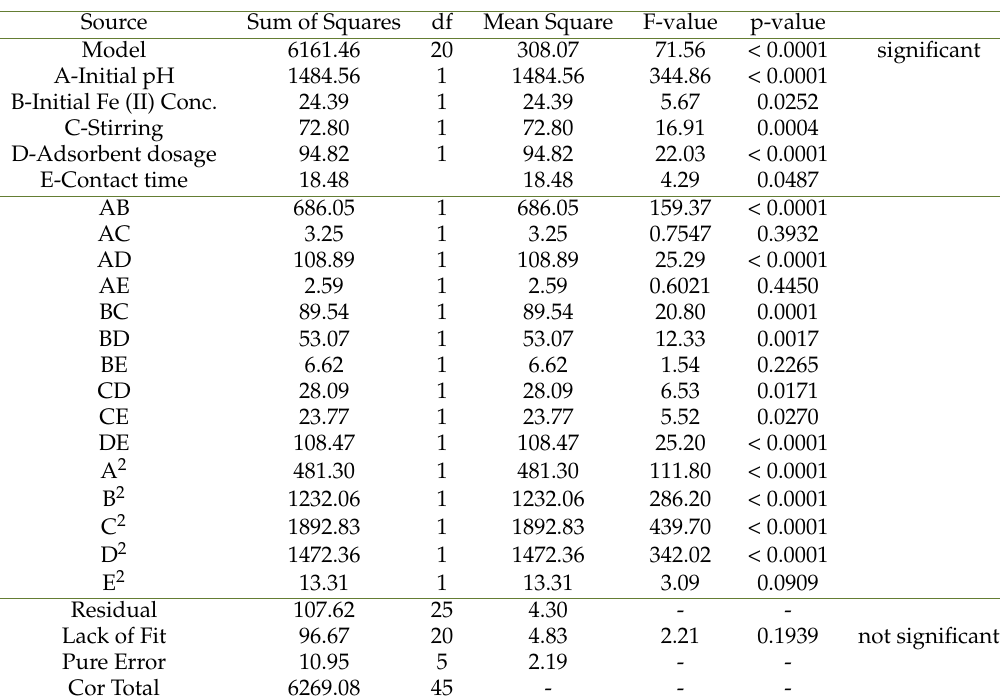
Table 4. ANOVA for Quadratic